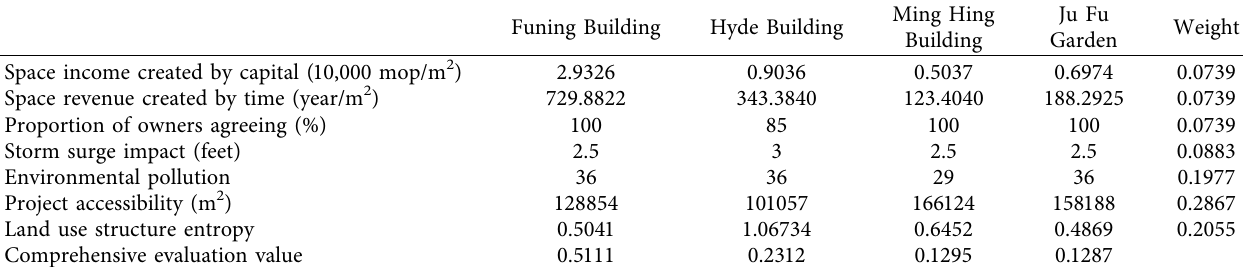
Table 4: Evaluation of Macau urban renewal site selection beneft from the perspective of spatial beneft.